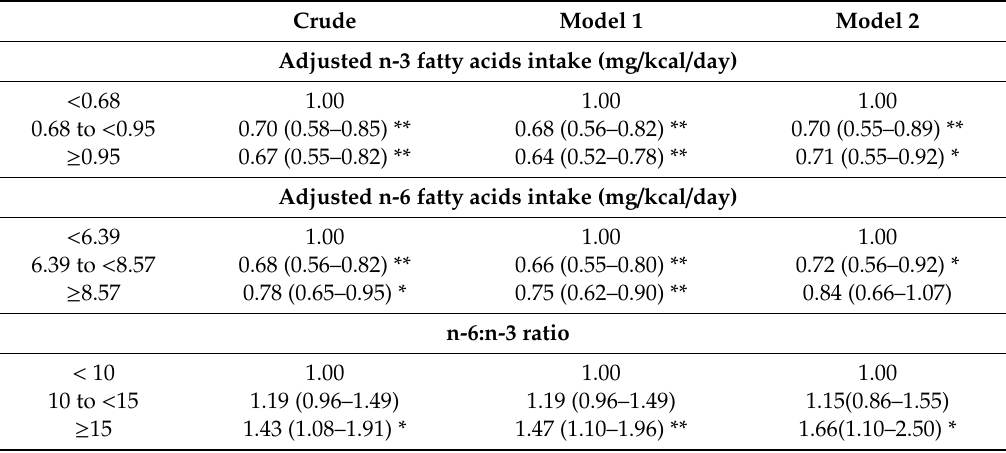
Table 2. The ORs (95% CIs) for depressive symptoms by adjusted dietary n-3 and n-6 fatty acids intake and n-6:n-3 ratio, NHANES 2009–2016 ( n = 17,431). Crude Model 1 Model